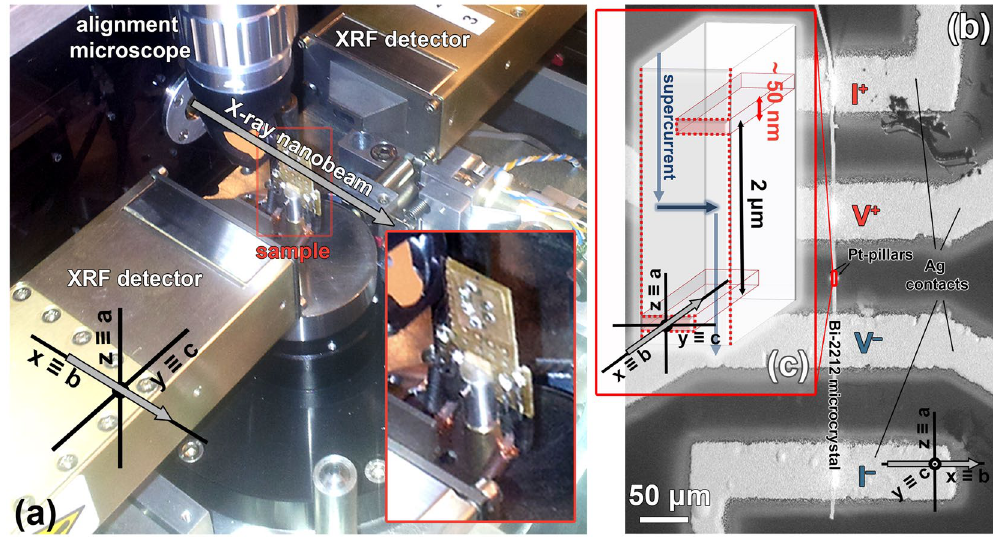
Figure 1. ( a ) Photograph of the experimental setup employed at the ESRF ID16B beamline showing the alignment optical microscope, the XRF detectors and the sample rotation stage around the z -axis of the laboratory reference frame. The inset reports a magnification of the sample holder used for the on-line electrical measurements: the chip containing the Bi-2212 micro-crystal is visible in the center of the sample holder. ( b ) Scanning electron microscope (SEM) image of a Bi-2212 micro-crystal mounted on the chip for electrical characterization. The voltage and current Ag electrodes for the on-line four-probes electrical measurements are labeled as V + , V − , I + and I − , respectively. The Pt pillars used for the alignment are visible between the voltage electrodes. ( c ) Schematic representation of the modifications induced by the trenches in the path of the superconducting current, designed to force it along the c -axis of the Bi-2212 micro-crystal across a stack of intrinsic Josephson junctions. The reference systems present in all the panels show the relative orientation of the laboratory frame ( x , y and z ) and the Bi-2212 crystal axes ( a , b and c ). The grey arrow represents the X-ray nano-beam.